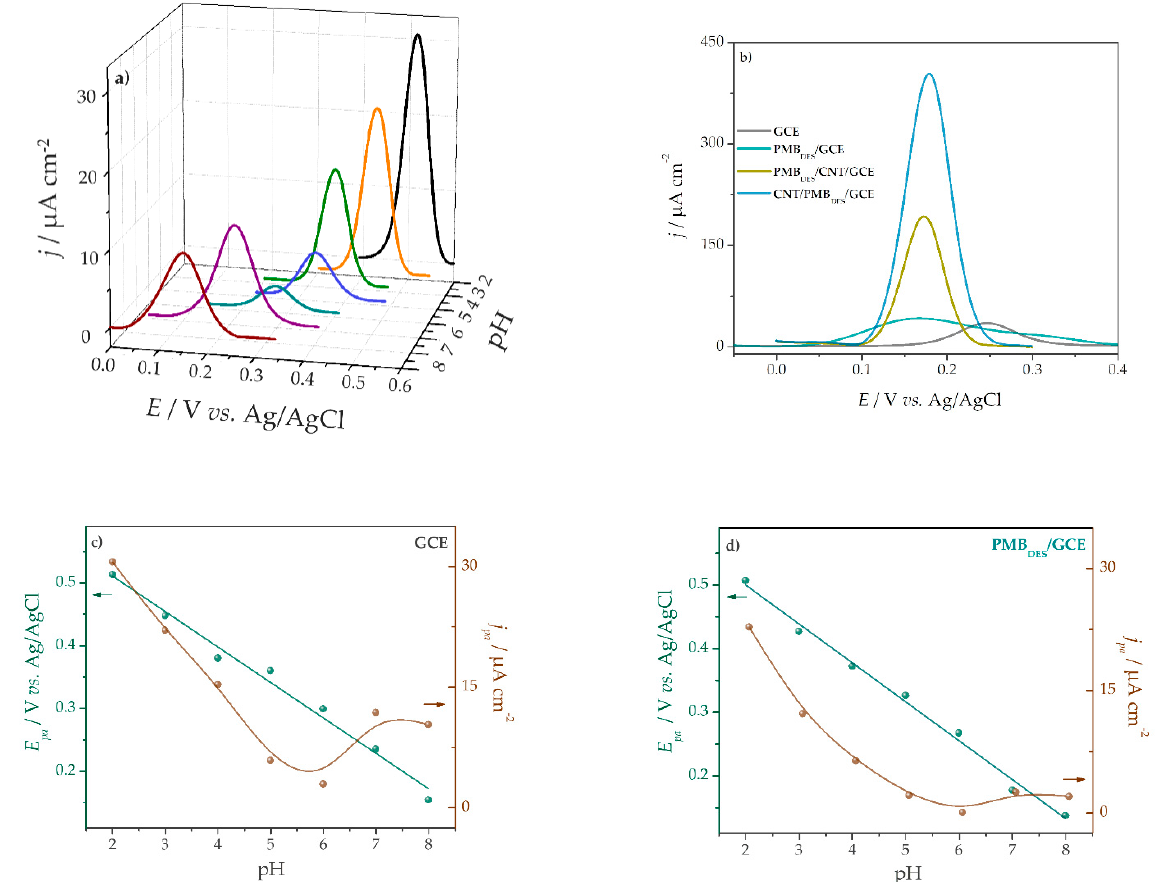
Figure 2. Differential pulse voltammograms DPVs ( v = 4 mV s − 1 ) of 50.0 µM 5-ASA in 0.04 M BR. ( a ) With glassy carbon electrode (GCE) in buffer solution from pH 2.0 to 8.0; ( b ) With different electrode architectures in buffer solution at pH 7.0. Effect of pH on 50.0 µM 5-ASA oxidation peak current, j pa (µA cm − 2 , ● ) and peak potential, E pa (V, ● ) with ( c ) GCE and ( d ) PMB DES /GCE, respectively.